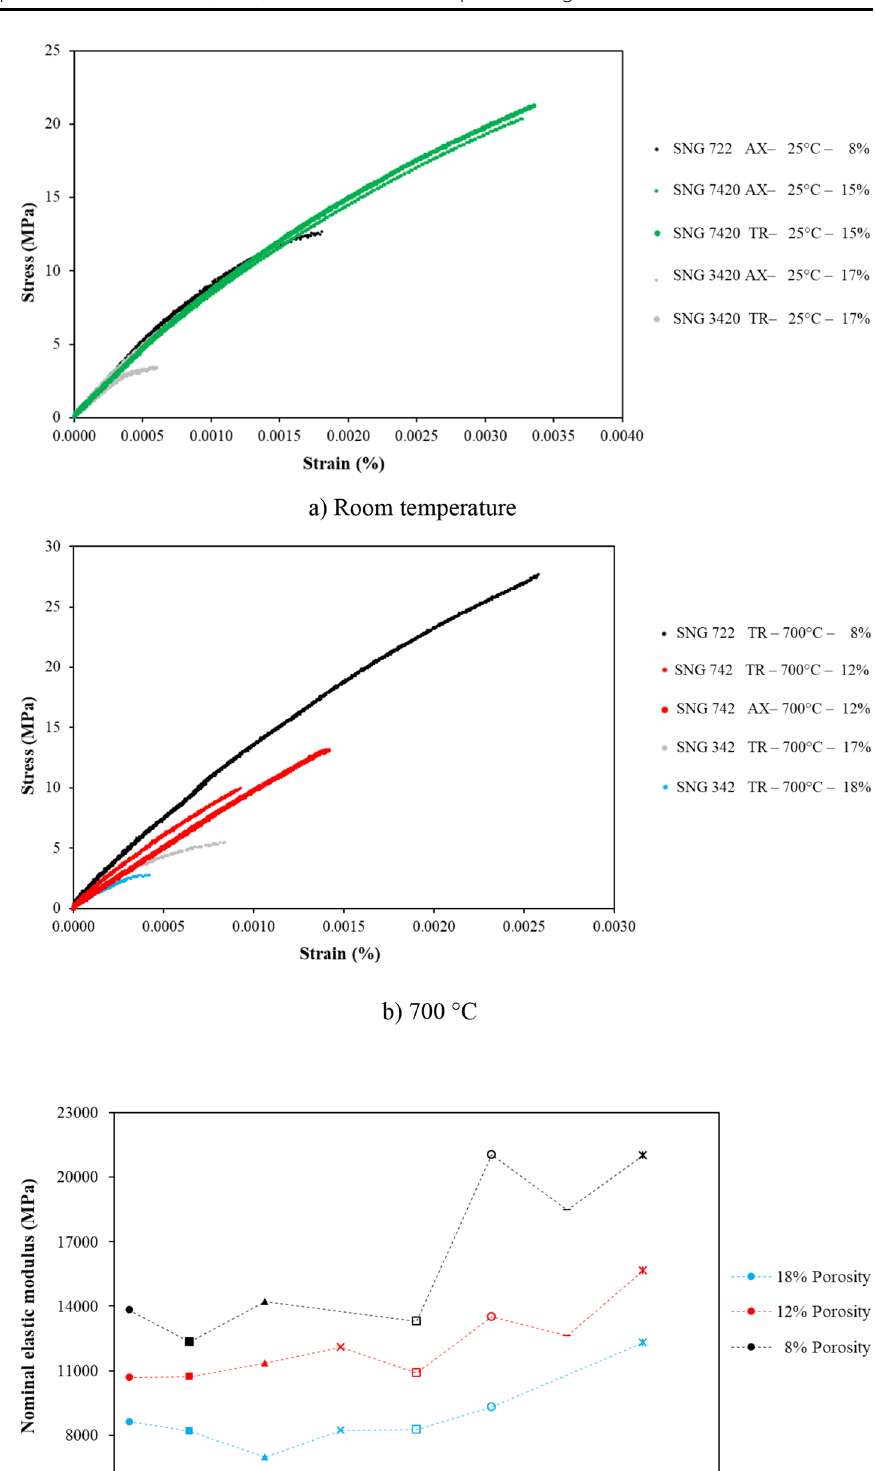
Fig. 6 Tensile stress-strain curves corresponding to a pro- portion of specimens tested to failure using the ETMT rig at: a Room temperature; b 700 °C. TR and AX stand for specimens prepared in transverse and axial directions (based on the orientation of the original bil- lets), respectively